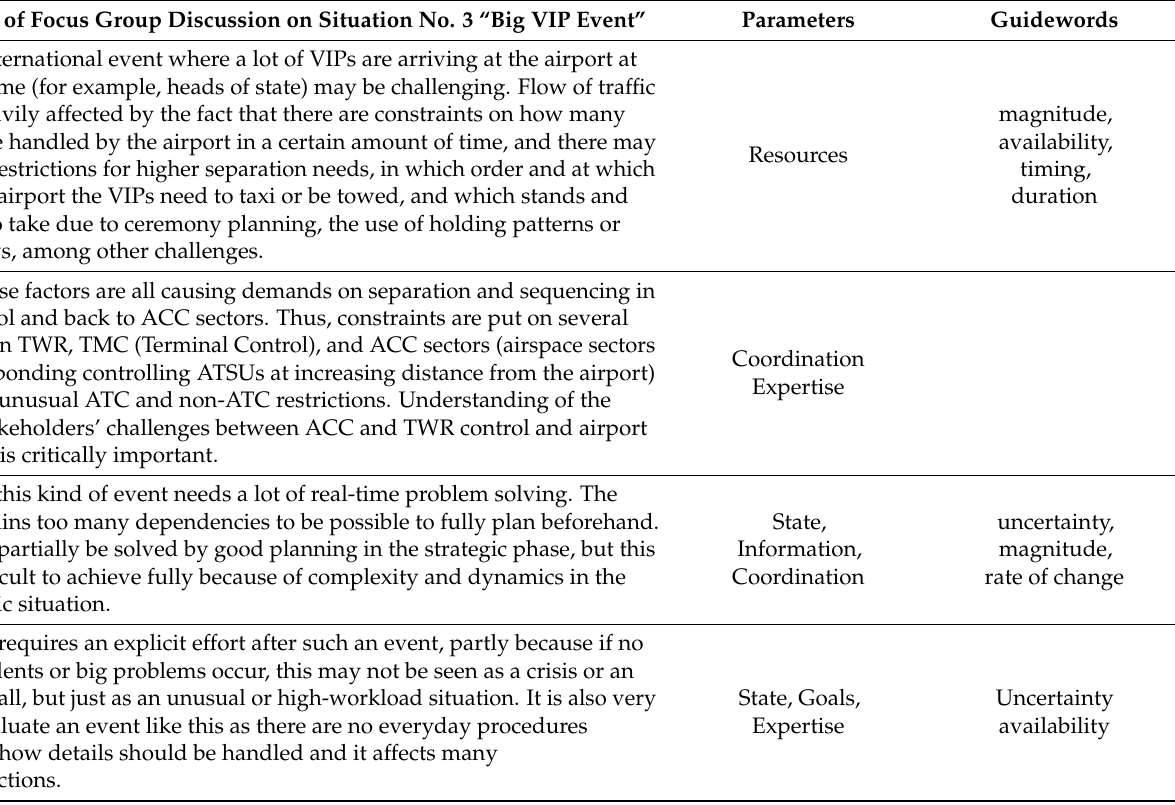
Table 5. Challenging situation No. 3 “Big VIP event” scenario discussion summary from Case